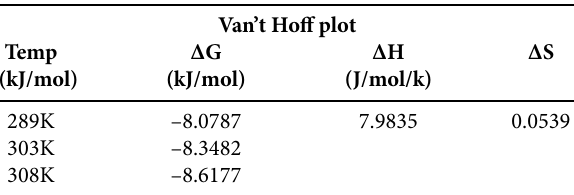
Table 7. Thermodynamic results of As(V) adsorption at different temperatures